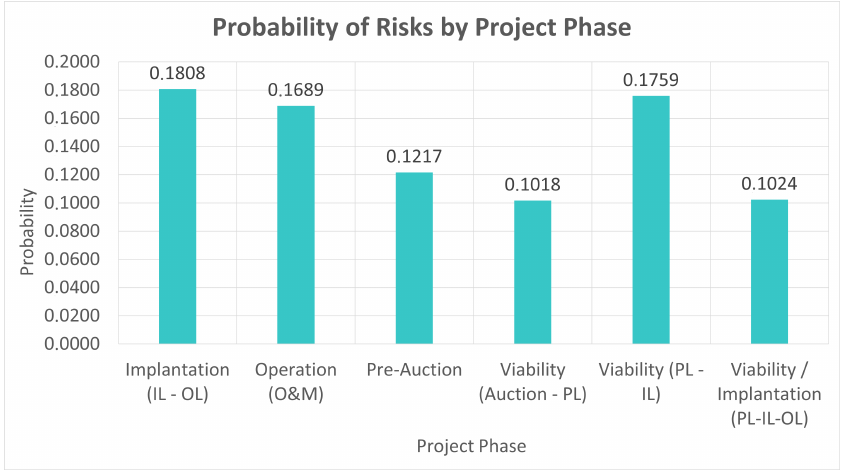
Figure 8. Risk probability per phase. Those project phases are implantation, operation, pre-auction, and viability. This accounts for the average risk probability for all risks that fall within each particular project